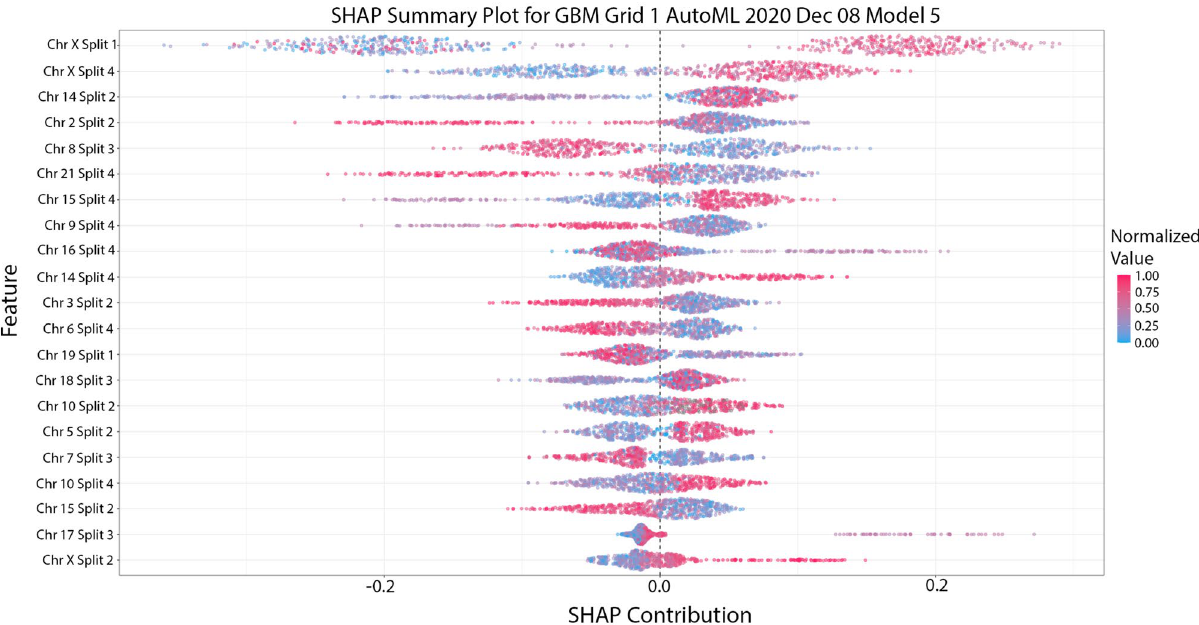
quarter of chromosome